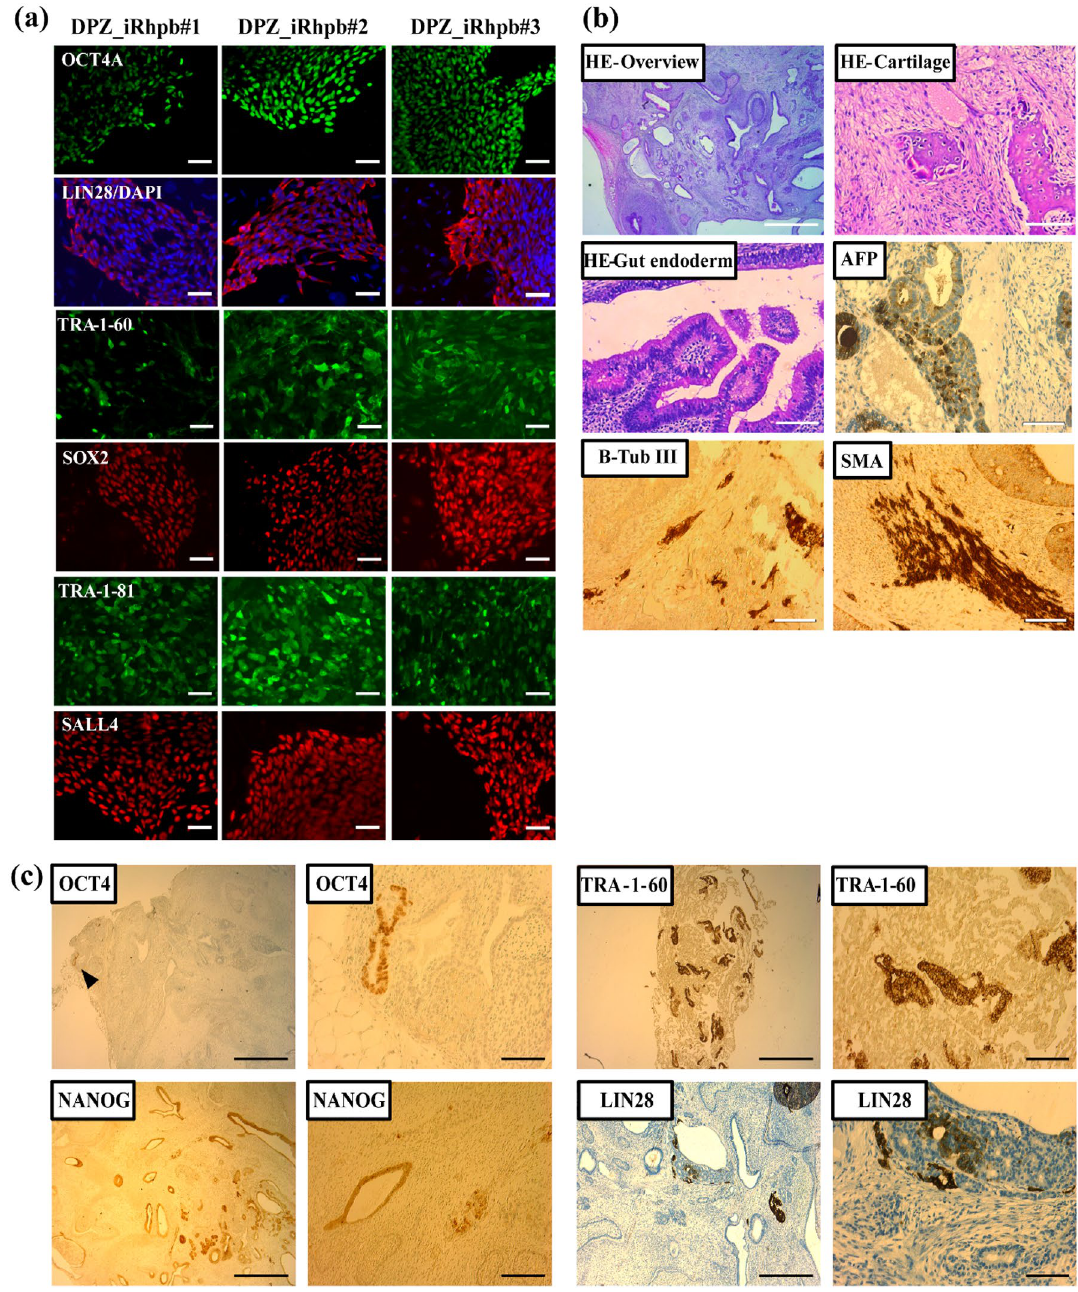
Figure 2. Rhesus iPSC characterization. ( a ) Immunofluorescence staining of Rhesus iPSC colonies of lines DPZ_iRhpb#1–3 in feeder culture. Detection of pluripotency markers OCT4A, LIN28, TRA-1-60, SOX2, TRA-1-81, and SALL4. TRA-1-81, TRA-1-60, and SALL4 are not contained in the reprogramming construct. The origin of OCT4A, LIN28, and SOX2 expression cannot be determined (Scale bar 20 µm). ( b , c ) Immunohistochemical analysis of a DPZ_iRhpb#2-derived teratoma. ( b ) Teratoma sections were stained for representative markers of the three germ layers: β-Tubulin III staining indicates ectodermal differentiation. Smooth muscle actin and AFP staining show mesodermal and endodermal differentiation, respectively. HE staining allows the identification of representative tissues. The presence of cartilage indicates mesoderm, and gut endoderm shows endodermal differentiation (Scale bars 100 µm). ( c ) The DPZ_iRhpb#2 teratoma also expressed pluripotency markers OCT4A, NANOG, TRA-1-60, and LIN28. Small isolated clusters were found positive for the pluripotency markers tested (left image of each pair of images: scale bar 1 mm; right image: scale bar 100